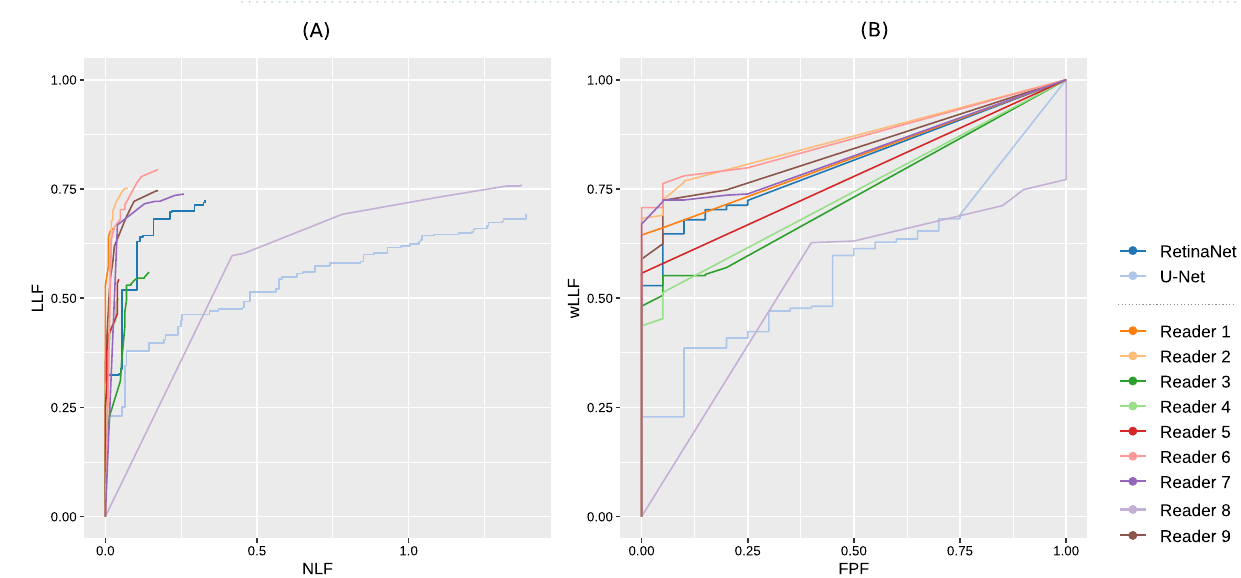
Figure 2. Localization of false negative and false positive predictions in the reader study. Backgrounds were determined by averaging over all reader study radiographs. ( A ) All inserted nodules of different sizes in all radiographs marked blue. ( B – J ) False negative and false positive predictions by reader. ( K ) Location of false negative predictions of RetinaNet and false positive predictions of RetinaNet. ( L ) False negative predictions of U-Net and false positive predictions of U-Net.